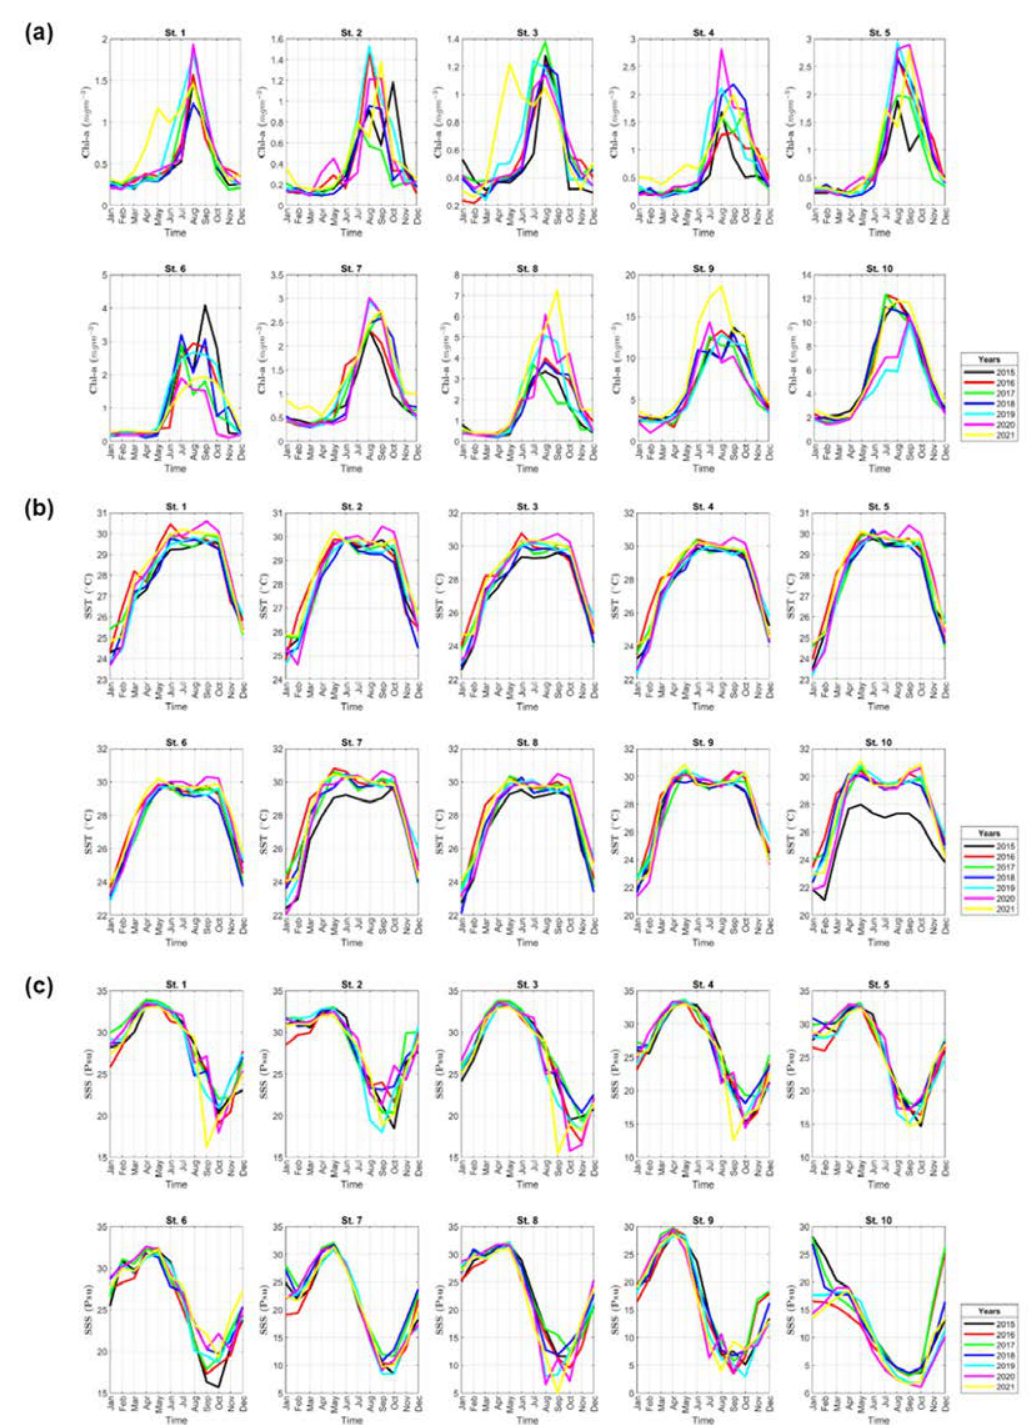
Fig. 3: Data of (a) Chl‐a, (b) SST, and (c) SSS from Stations 1 to 10 for seven years (2015 to 2021)